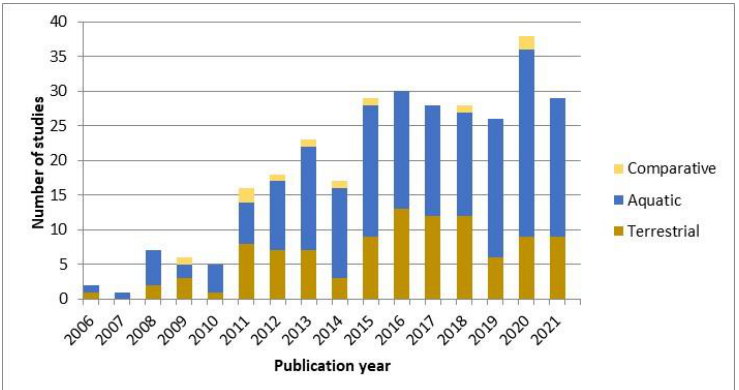
Figure 2. The number of studies published from 2006 to 2021 and selected for this review according to the eligibility criteria ( n = 303), targeting aquatic, and terrestrial environments, and their combination (comparative